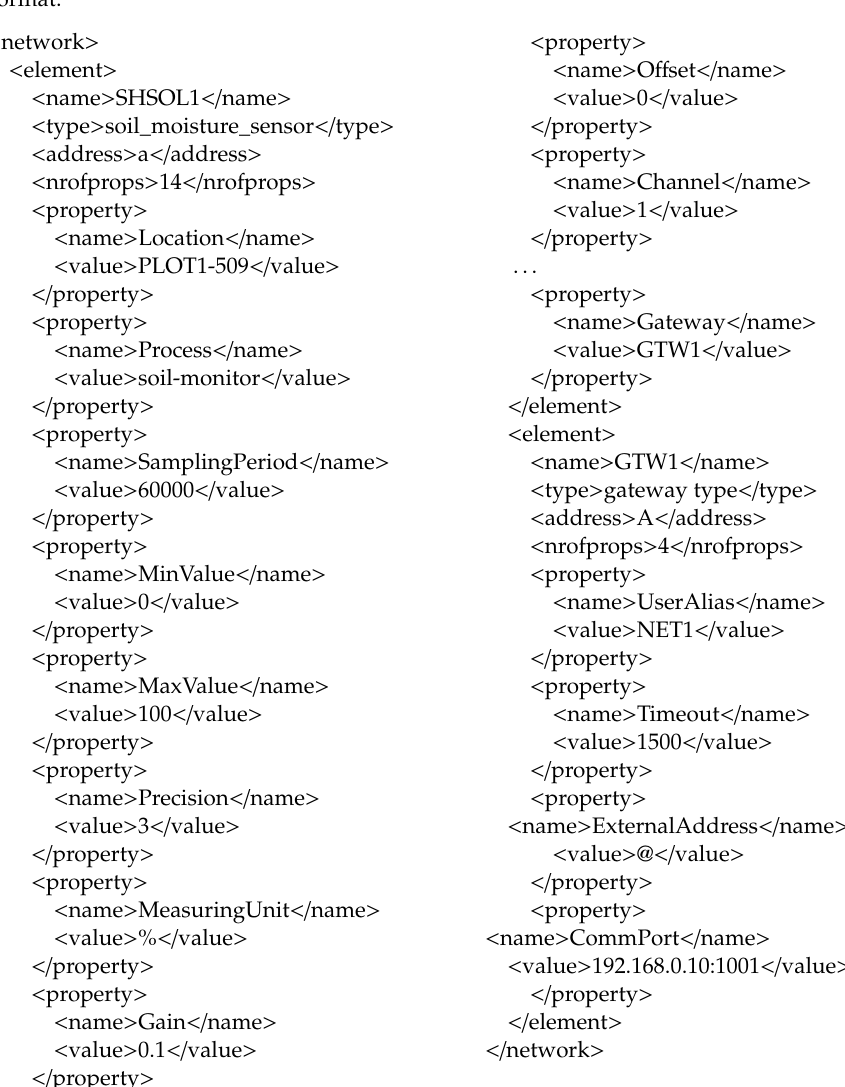
Table 5. Example configuration for a soil moisture sensor and a gateway module represented in XML